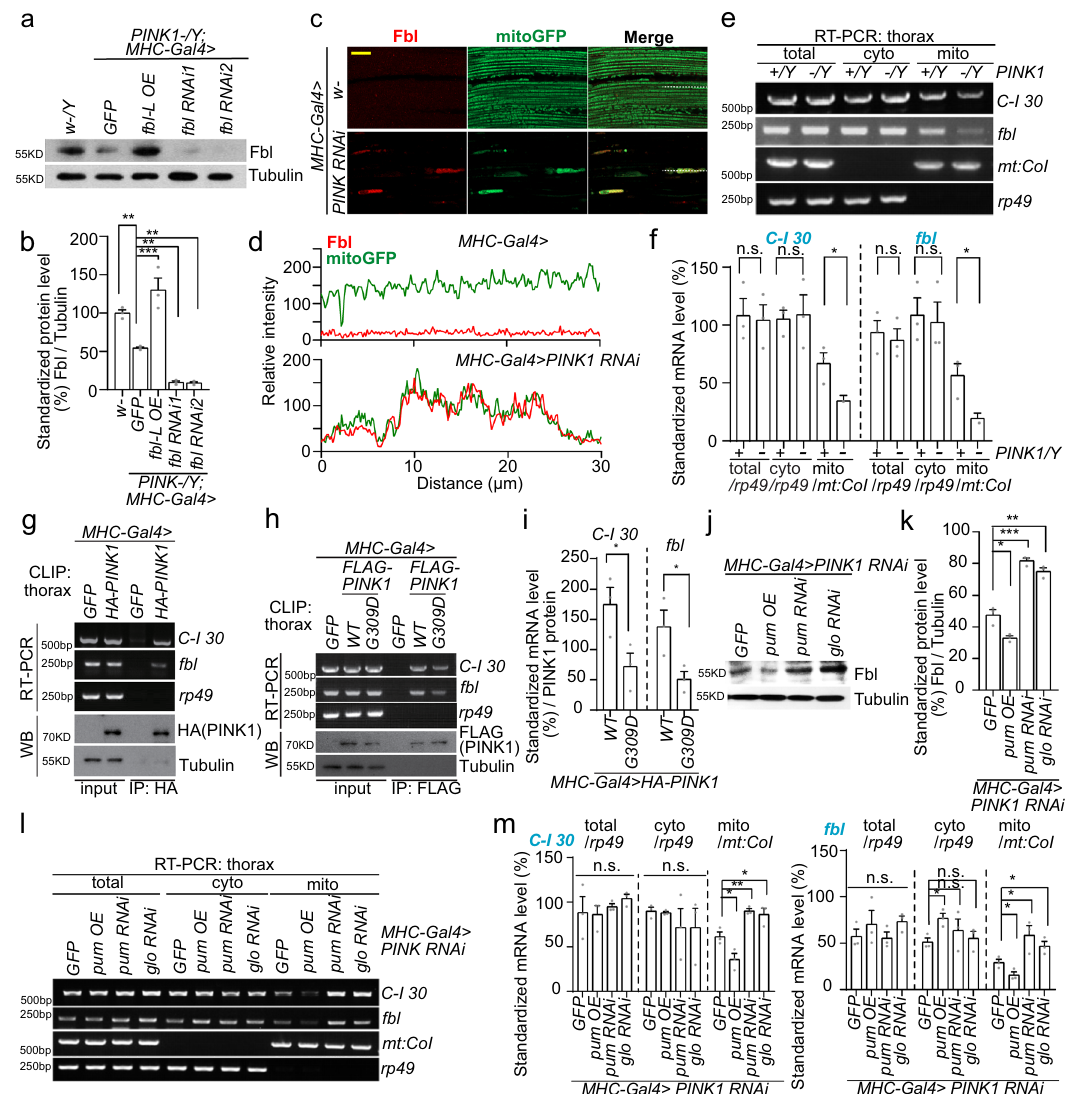
Fig. 7 PINK1/Parkin Pathway Regulates fbl mRNA Translation on OMM. a Immunoblot of Fbl protein levels in WT ( w-/Y ) and PINK1 mutant showing the regulation by PINK1. Tubulin serves as loading control. b Quanti fi cation of a n = 3 biologically independent samples. In this and all subsequent immunoblot and RT-PCR quanti fi cations, 3 independent biological repeats were measured per genotype. c Immunostaining of Fbl and mitoGFP signals showing the mitochondrial localization of Fbl in PINK1 RNAi fl y muscles. Scale bar, 25 µ m. d Colocalization analysis of c . e Semiquantitative RT-PCR of fbl mRNA in PINK1 mutant muscle. mRNAs prepared from total, cytosol (cyto), or mitochondrial (mito) fractions were used. Mitochondrial genome encoded gene mt:CoI serves as mitochondrial loading control; rp49 serves as total and cytosol loading controls. f Quanti fi cation of e . For RT-PCRs in ( e and l ), n = 3 biologically independent samples. g CLIP assays showing PINK1 binding to fbl mRNA in fl y. C-I30 and rp49 mRNAs served as positive and negative control,